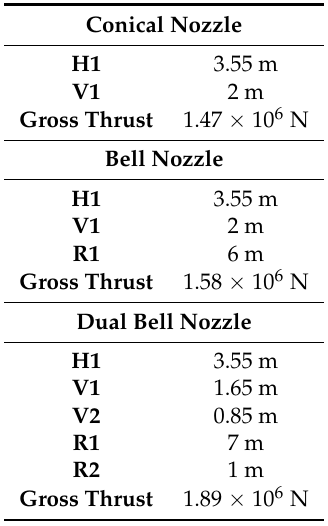
Table 8. Principal dimensions and final thrust levels achieved by the three nozzles